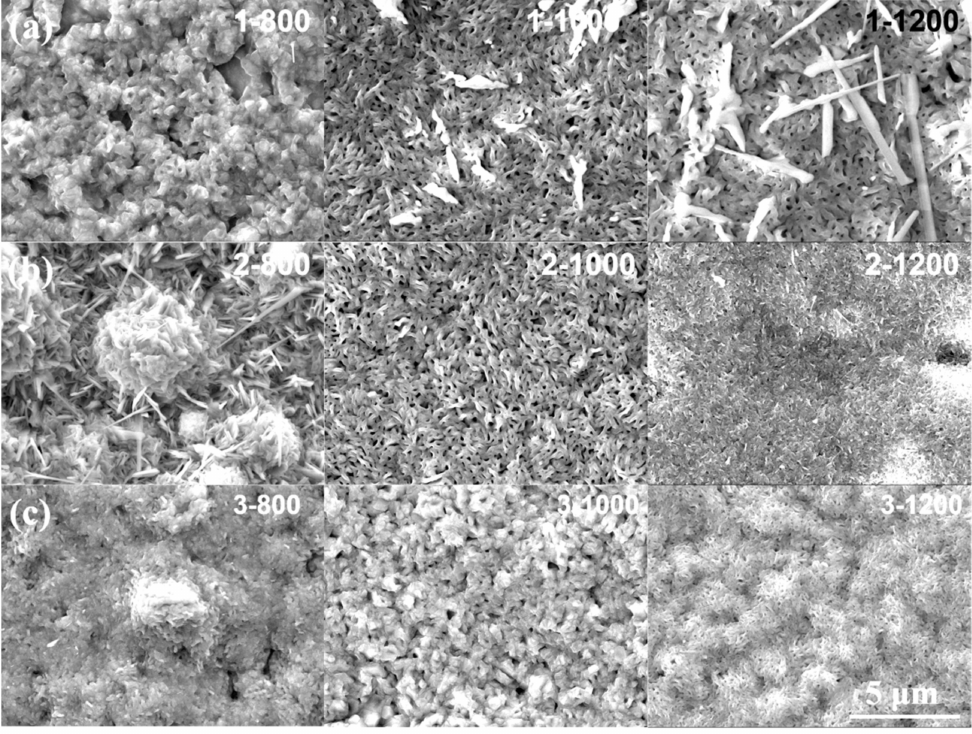
Figure 8. Oxidation surface morphology of coating samples by oxidation at different temperatures. ( a ) 1#, ( b ) 2# and ( c )